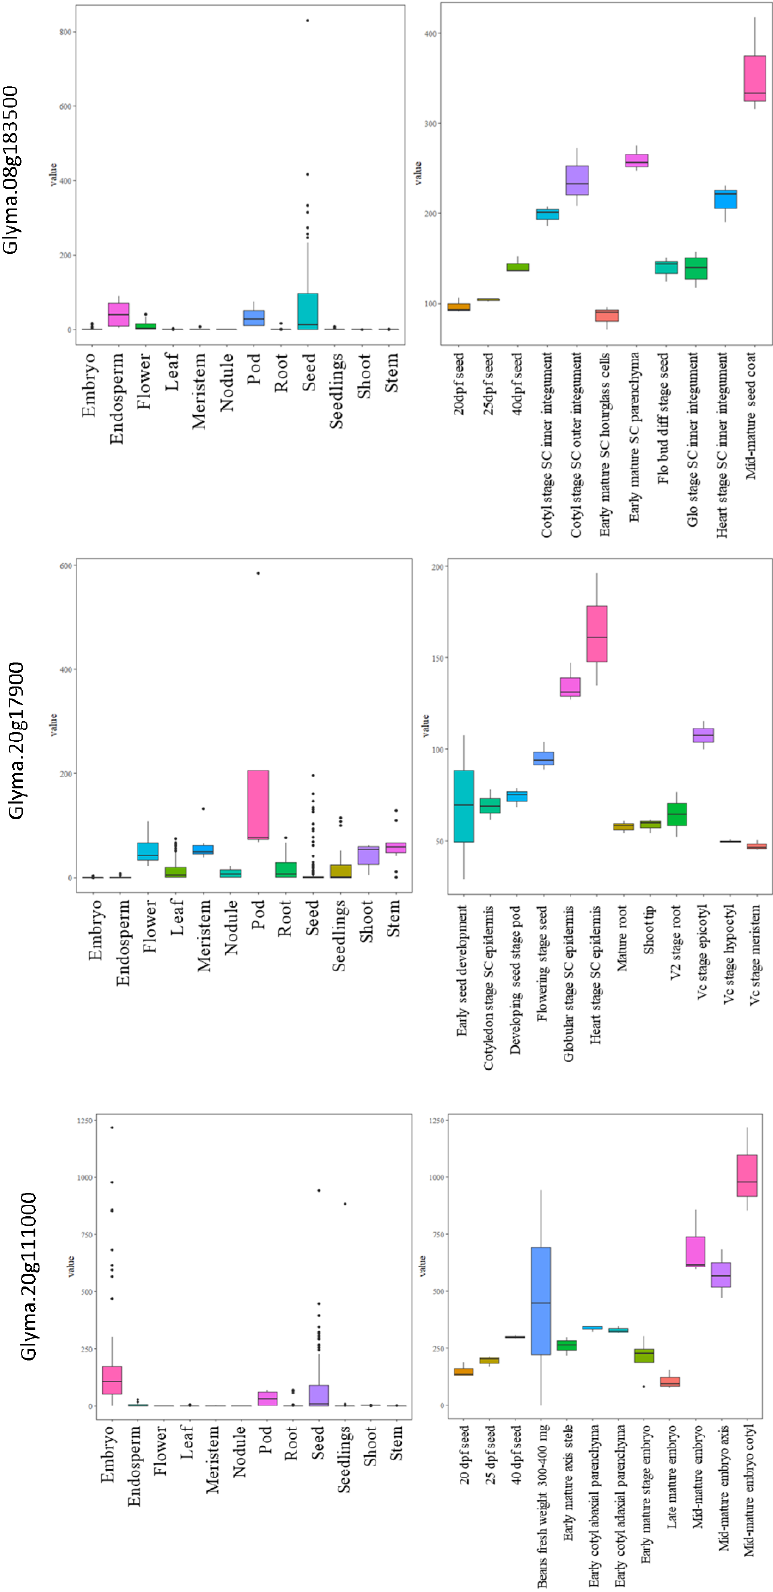
Figure 6. Expressions of three candidate genes related to the seed oil and protein content in different tissues and development stages in soybean.